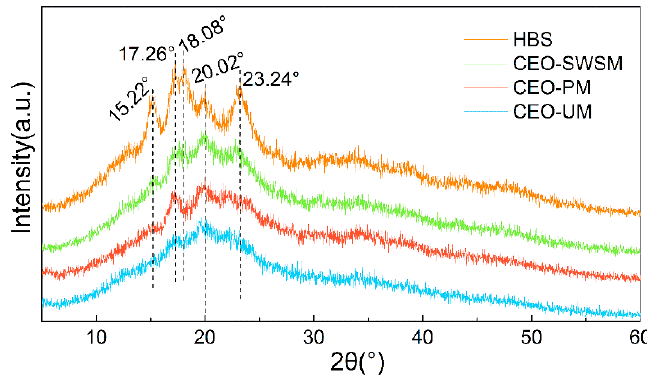
Figure 1. X-ray diffraction (XRD) patterns of highland barley starch (HBS) and the CEO-SWSM, Figure 1. X-ray di ff raction (XRD) patterns of highland barley starch (HBS) and the CEO-SWSM, CEO-PM, and CEO-UM microcapsules. CEO-PM, and CEO-UM